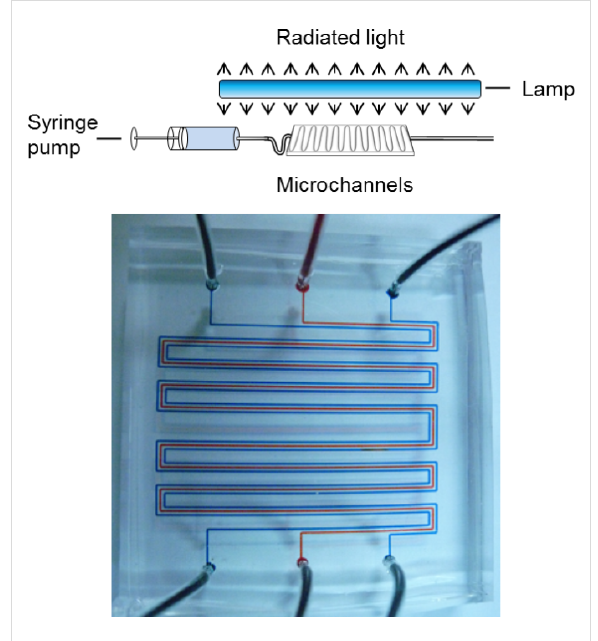
Figure 3: Schematic of a typical microflow photochemical reactor (above) and detail of a triple-channel microflow reactor (below) used for the photooxygenation of citronellol